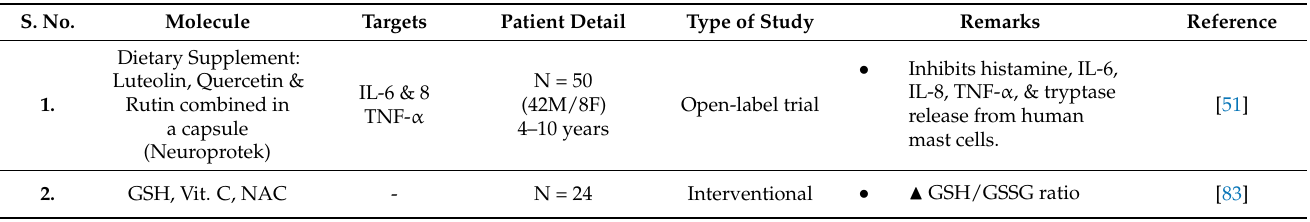
Table 2. Clinical studies related to natural anti-inflammatory agents targeting inflammatory pathways for ASD